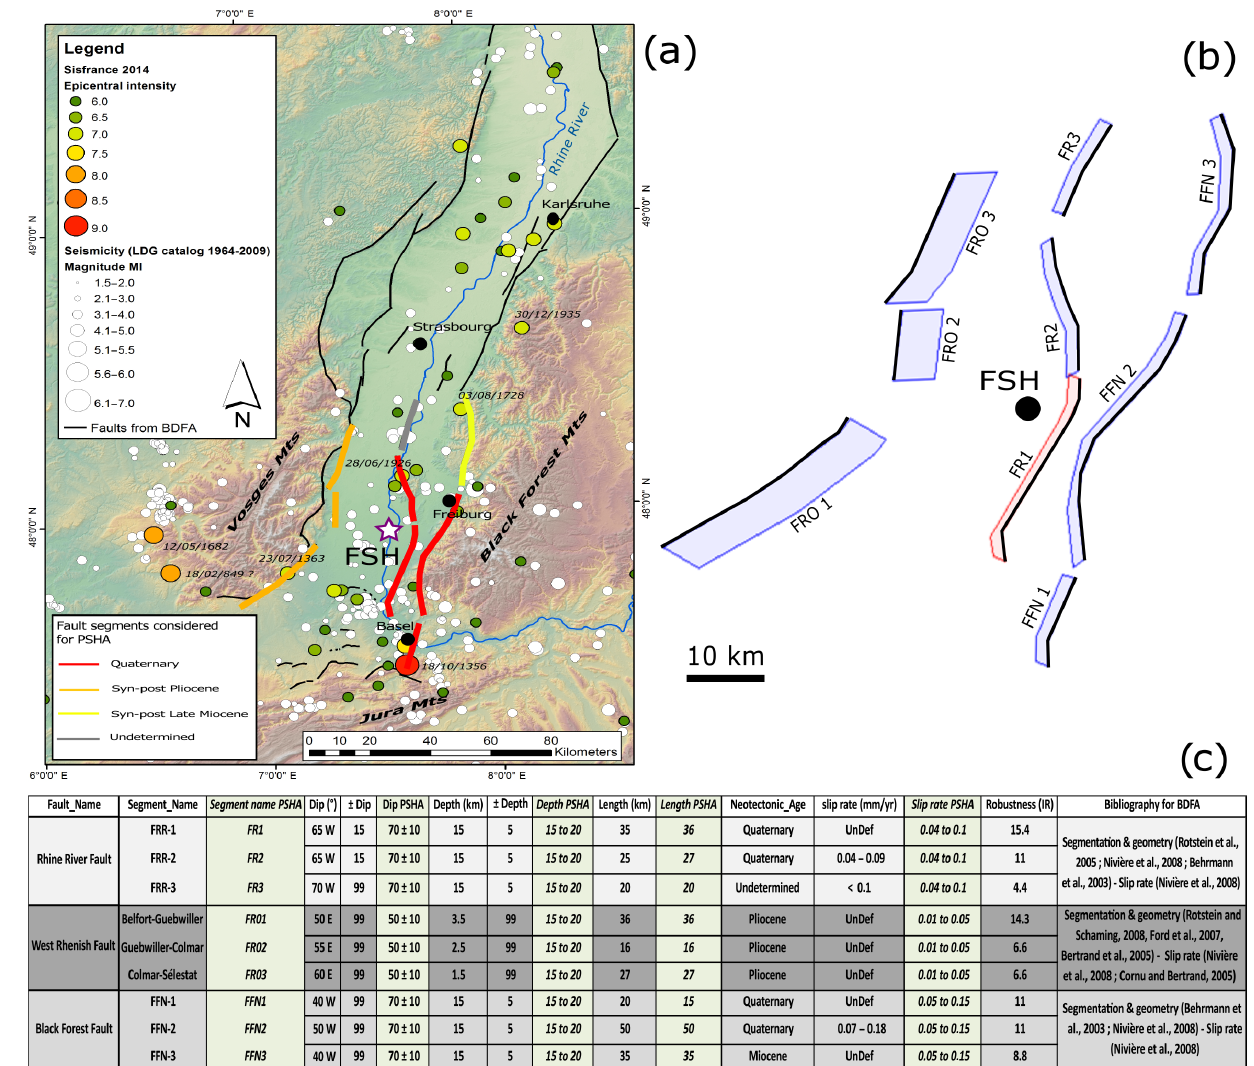
Figure 5. (a) Potentially active faults from BDFA (in black), selected segments for PSHA calculation in colour (depending on the age of the last movement on the fault). (b) Fault source model as produced for PSHA and extracted from CRISIS2014. Black lines correspond to the surficial trace of the fault segments, in light blue is the projection of fault planes at the surface (taking into account a 15km depth and the maximum dip angle), in light red is the closest fault to FSH (Fessenheim NPP). (c) Table containing the principal parameters from BDFA (grey columns) and their transposition into the parametric PSHA fault source model (light green columns). Unknown data are reported Undef or 99 in the BDFA